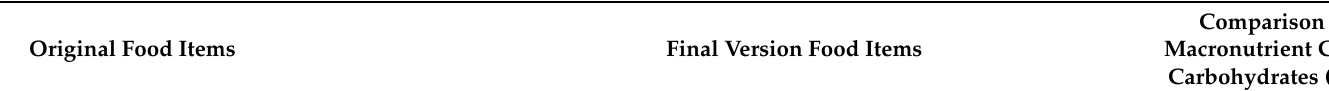
Table 2. Cultural adaptation and substitution of the original instrument items for Italian